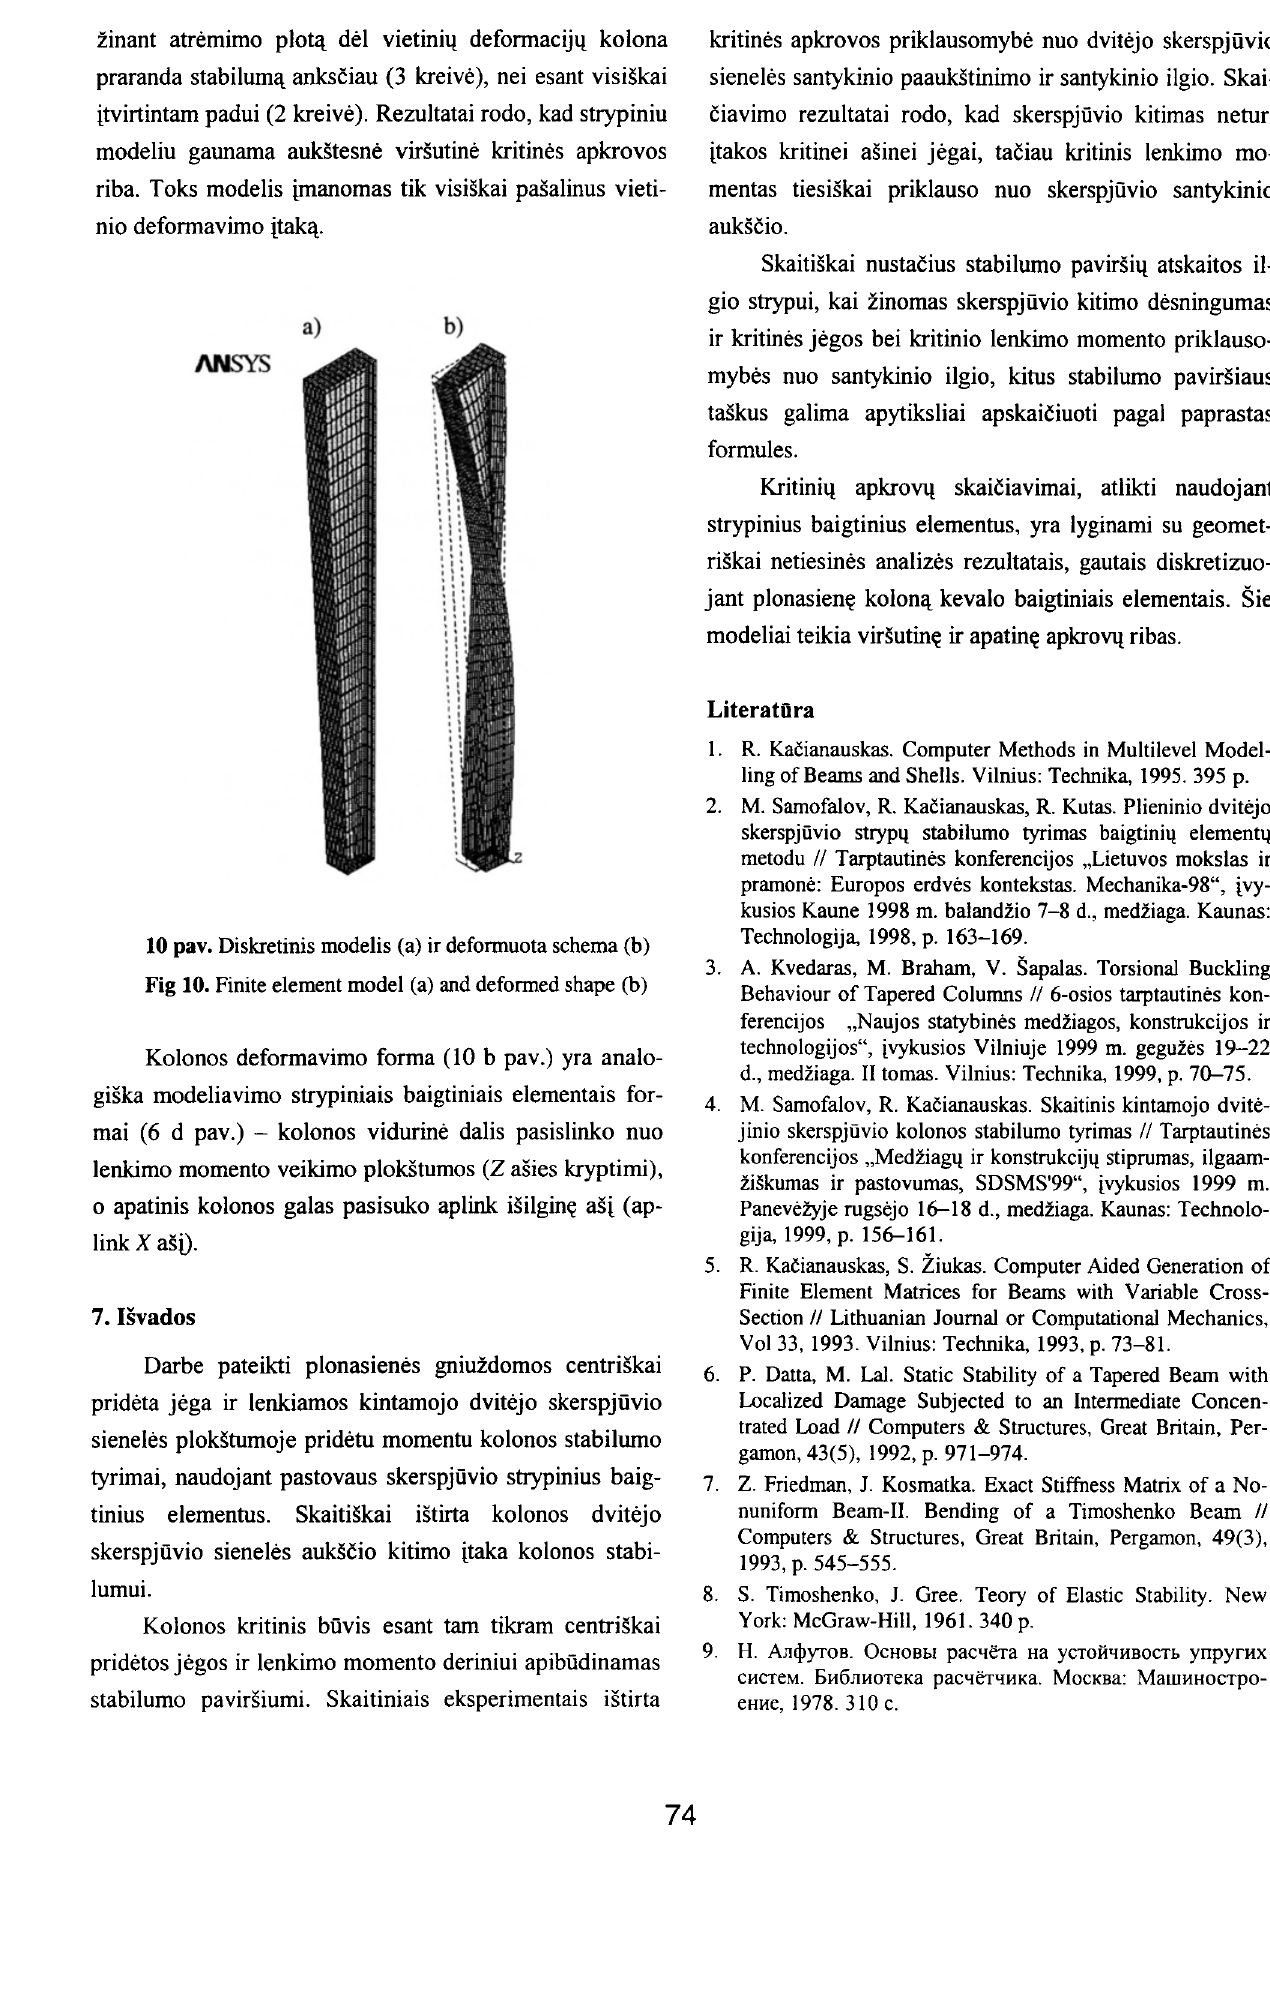
Fig 10. Finite element model (a) and deformed shape (b) Kolonos deformavimo forma (10 b pav.) yra analo giska modeliavimo strypiniais baigtiniais elementais for mai (6 d pav.) - kolonos vidurine dalis pasislinko nuo lenkimo momento veikimo plokstumos (Z asies kryptirni), o apatinis kolonos galas pasisuko aplink isilgin~ aiii (ap linkX